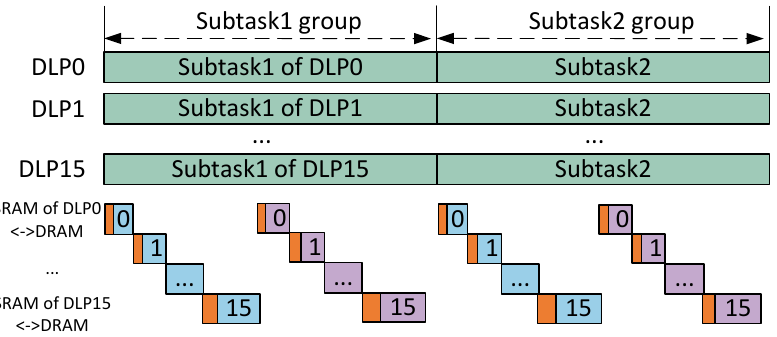
Figure 7. The relationship between the latency of access and the computing